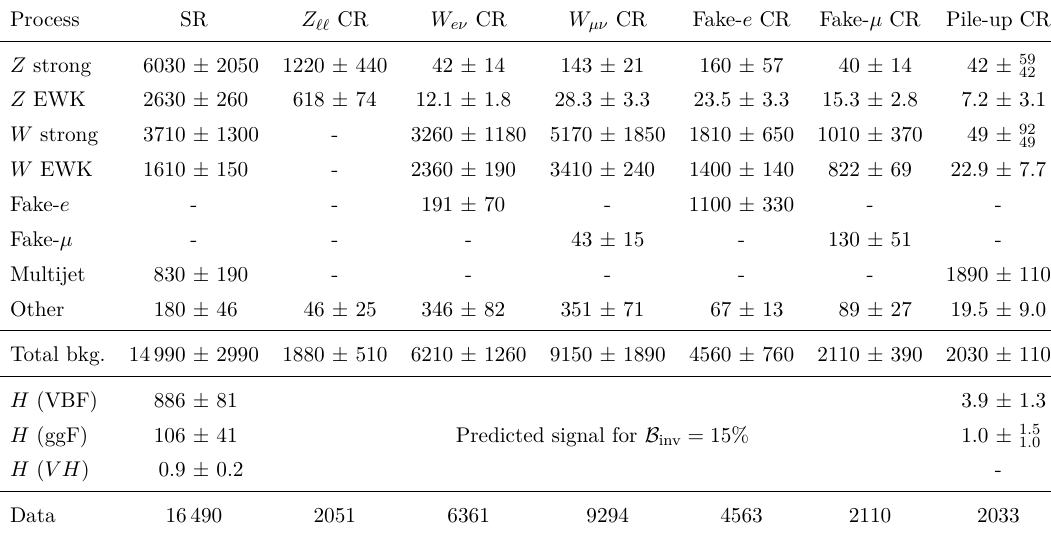
Table 5. Observed and expected background event yields with associated uncertainties in the signal region (SR) and control regions ( Z CR, W CR, W CR, fake- e CR, fake- µ CR, pile-up CR) ‘‘ eν µν prior to the likelihood fit. Minor backgrounds from t ¯ t , V V , V V V , and VBF H → W ∗ W / τ + τ − are combined and labelled ‘other’. The uncertainties in the backgrounds include the statistical, experimental, and theoretical uncertainties, taking into account the correlations between the individual SR and CR bins. The predicted signal yields (VBF, ggF, and V H ) for B = 15% inv (the observed limit) are presented for comparison. For all CRs with leptons, the contribution from the predicted signal is